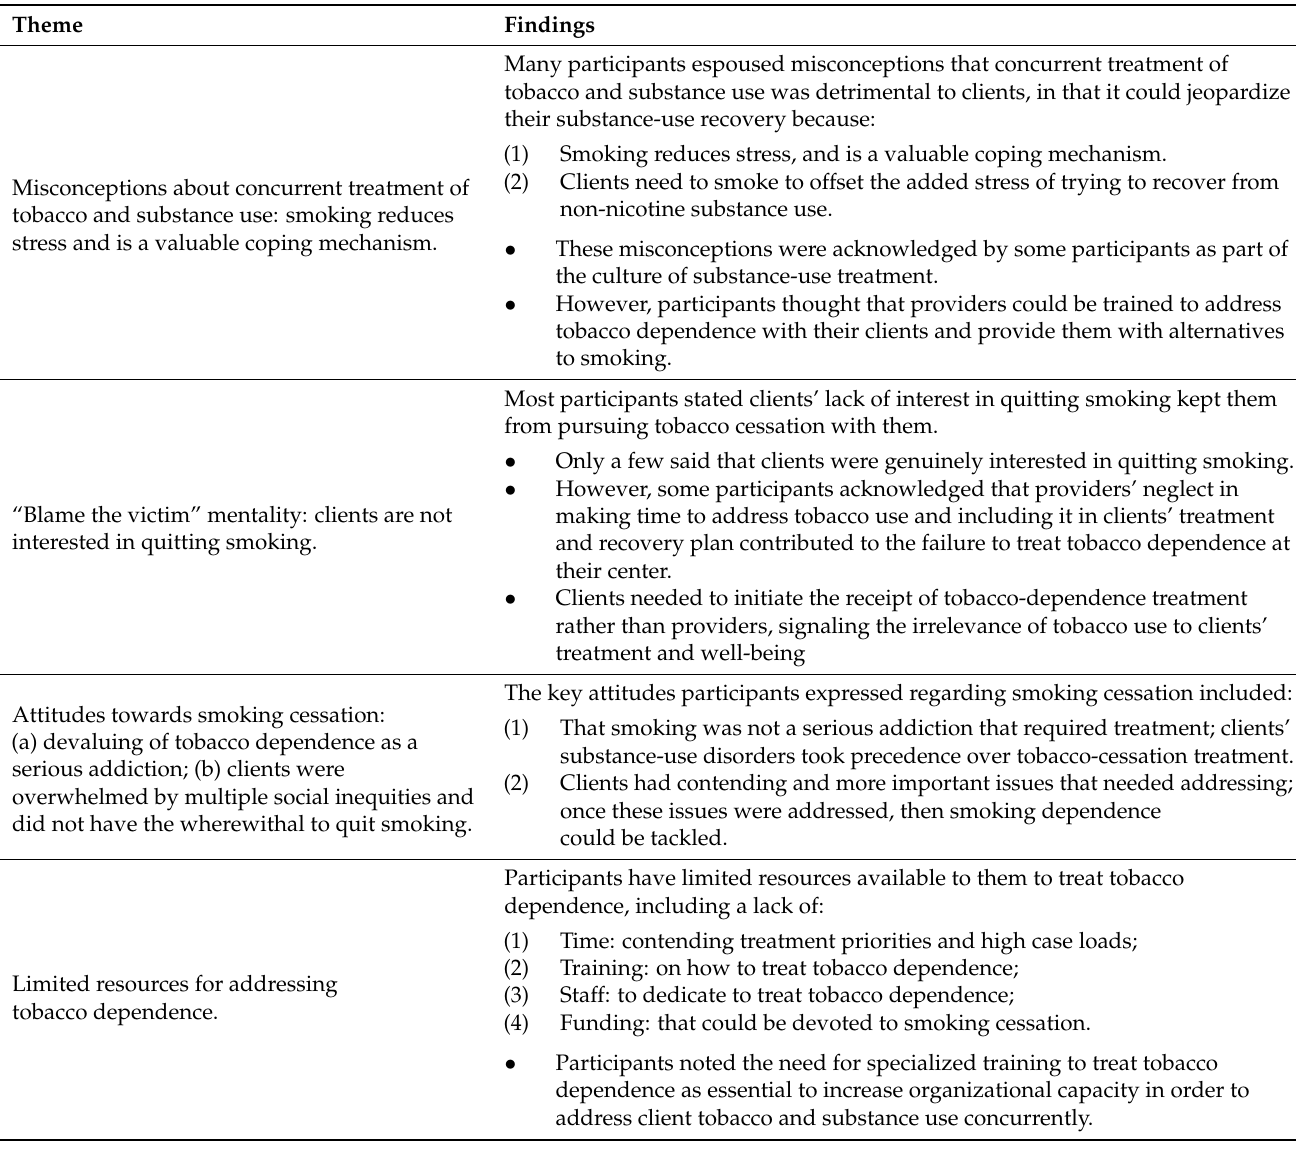
Table 3. Qualitative Analysis: Summary of Themes and